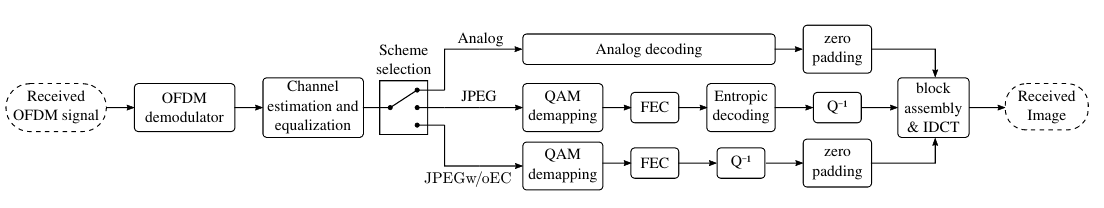
Figure 1. Block diagram of the transmission scheme.